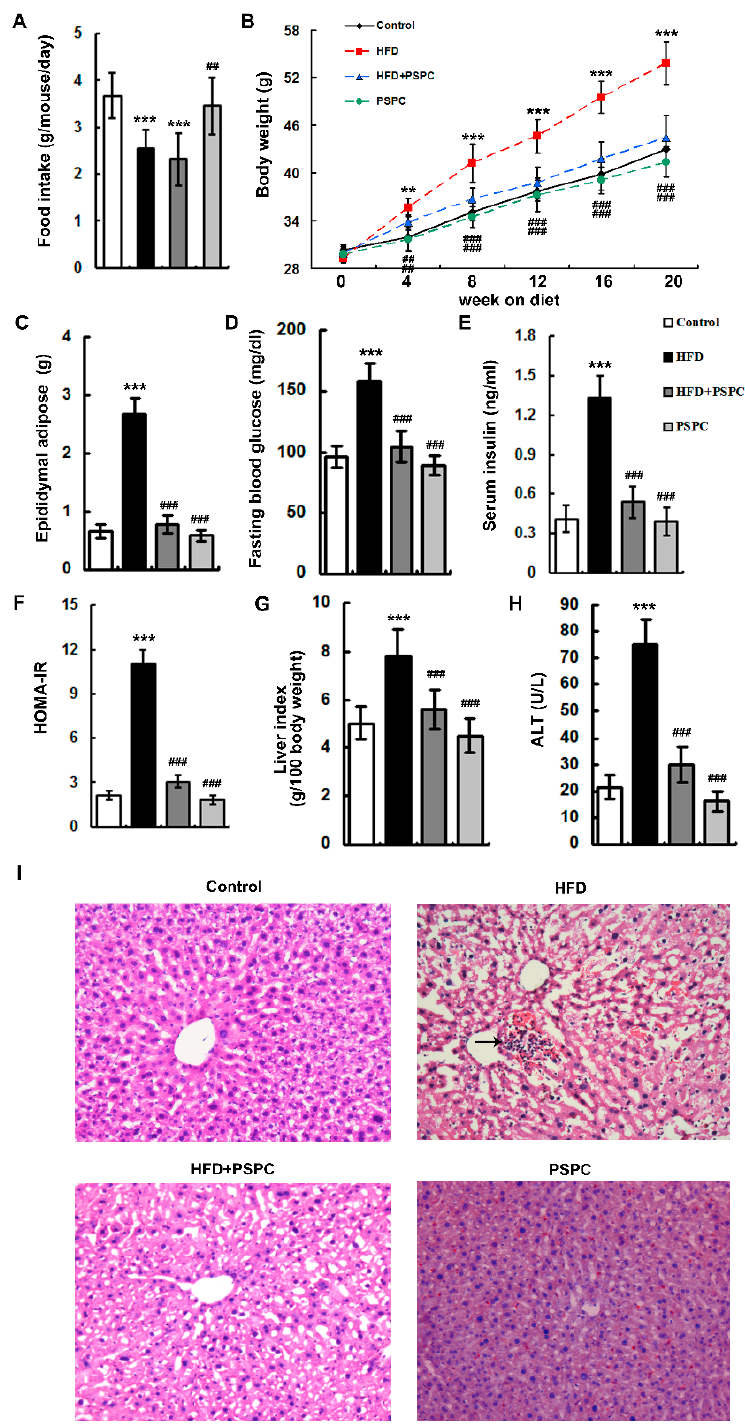
Figure 1. PSPC ameliorates obesity and liver injury in HFD-fed mice ( n = 5). ( A ) Food intake in all treated groups; ( B ) Total body weight in all treated groups; ( C ) The levels of epididymal adipose tissue masses in all treated groups; ( D ) The levels of fasting blood glucose in all treated groups; ( E ) The levels of serum insulin in all treated groups; ( F ) The levels of HOMA index in all treated groups; ( G ) The levels of liver index in all treated groups; ( H ) Serum ALT activities in all treated groups; ( I ) H&E staining of liver sections in all treated groups, 200 × magnification. Inflammatory cells are indicated by black arrow. All of the values are expressed as the mean ± SD. ** p < 0.01, *** p < 0.001 vs. the control group; ## p < 0.01, ### p < 0.001 vs. the HFD group.